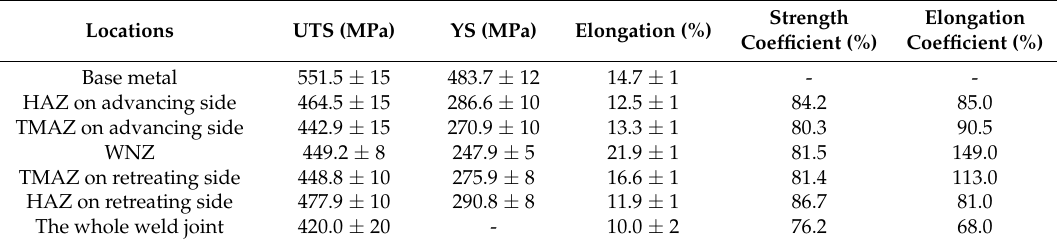
Figure 3. Engineering stress–strain curves for base metal, weld nugget zone, heat ‐ affected zone, thermos ‐ mechanically affected zone on the advancing side or the retreating side. Table 2. Tensile properties of FSW weld joints of 7A52 alloy.